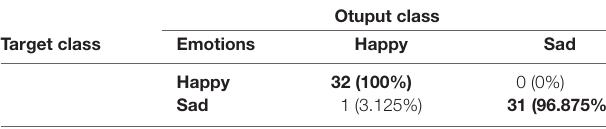
TABLE 5 | Confusion matrix for two emotional states.